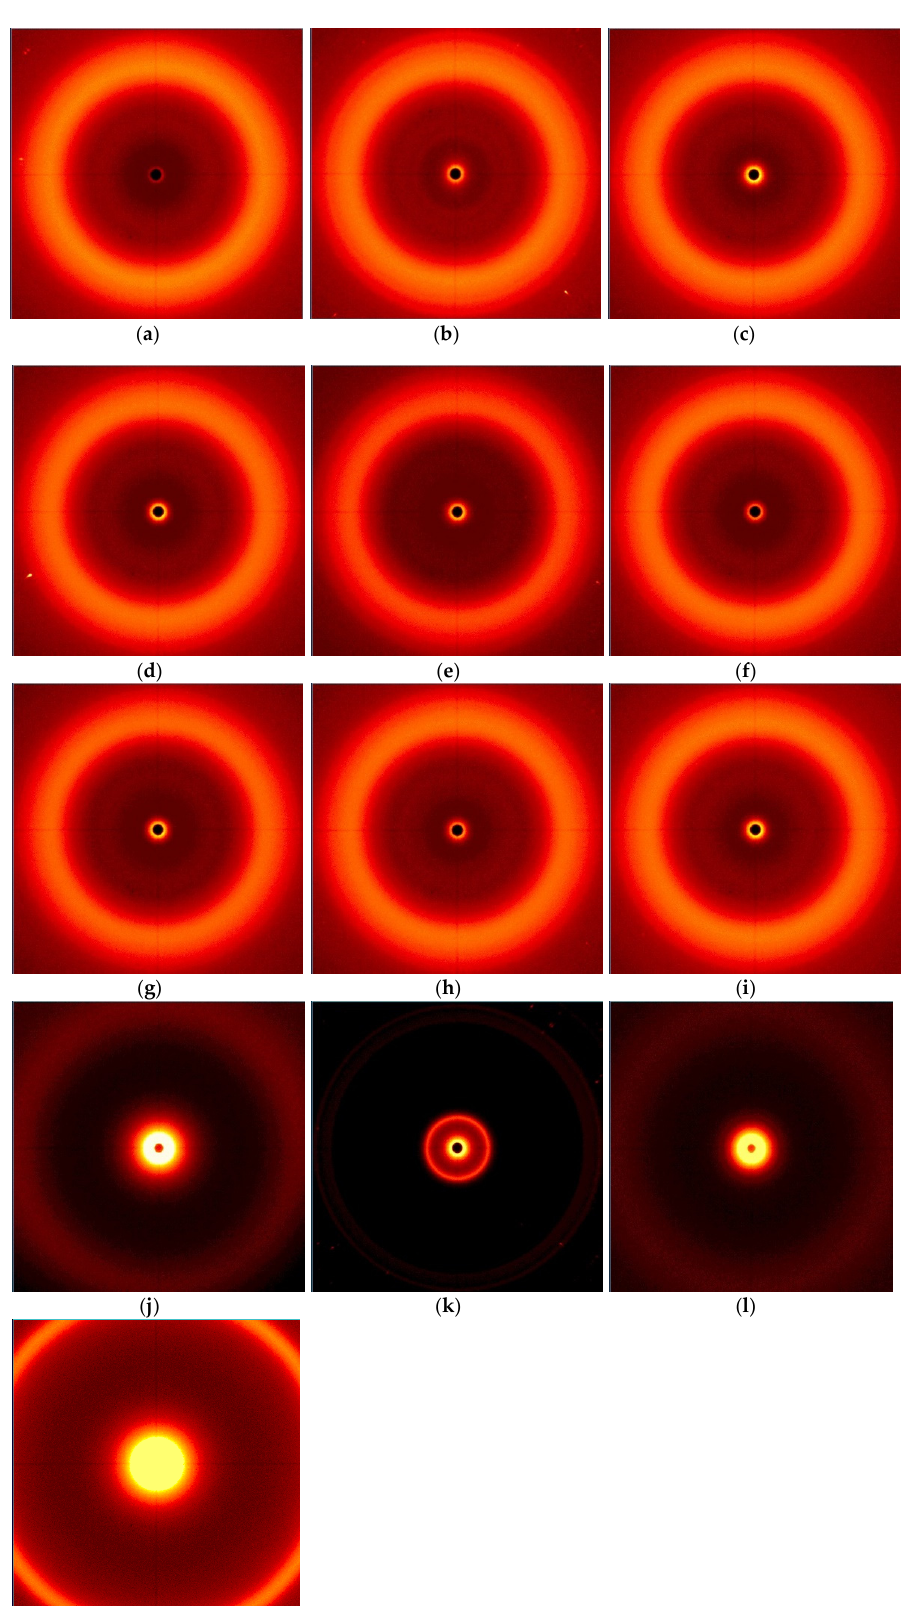
Figure 12. WAXS patterns: ( a ) fillers; ( b ) PC and composites with the addition of modified S, B, L and CN fillers; ( c ) PC and composites with the addition of modified fillers S, B and L.